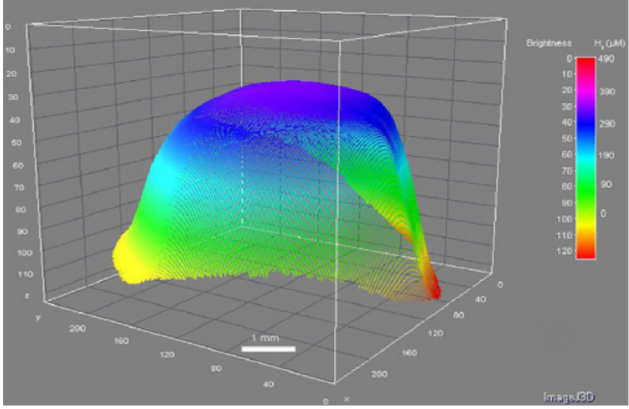
Figure 10. 3D figure of the change in brightness in the H 2 sensor area [35].